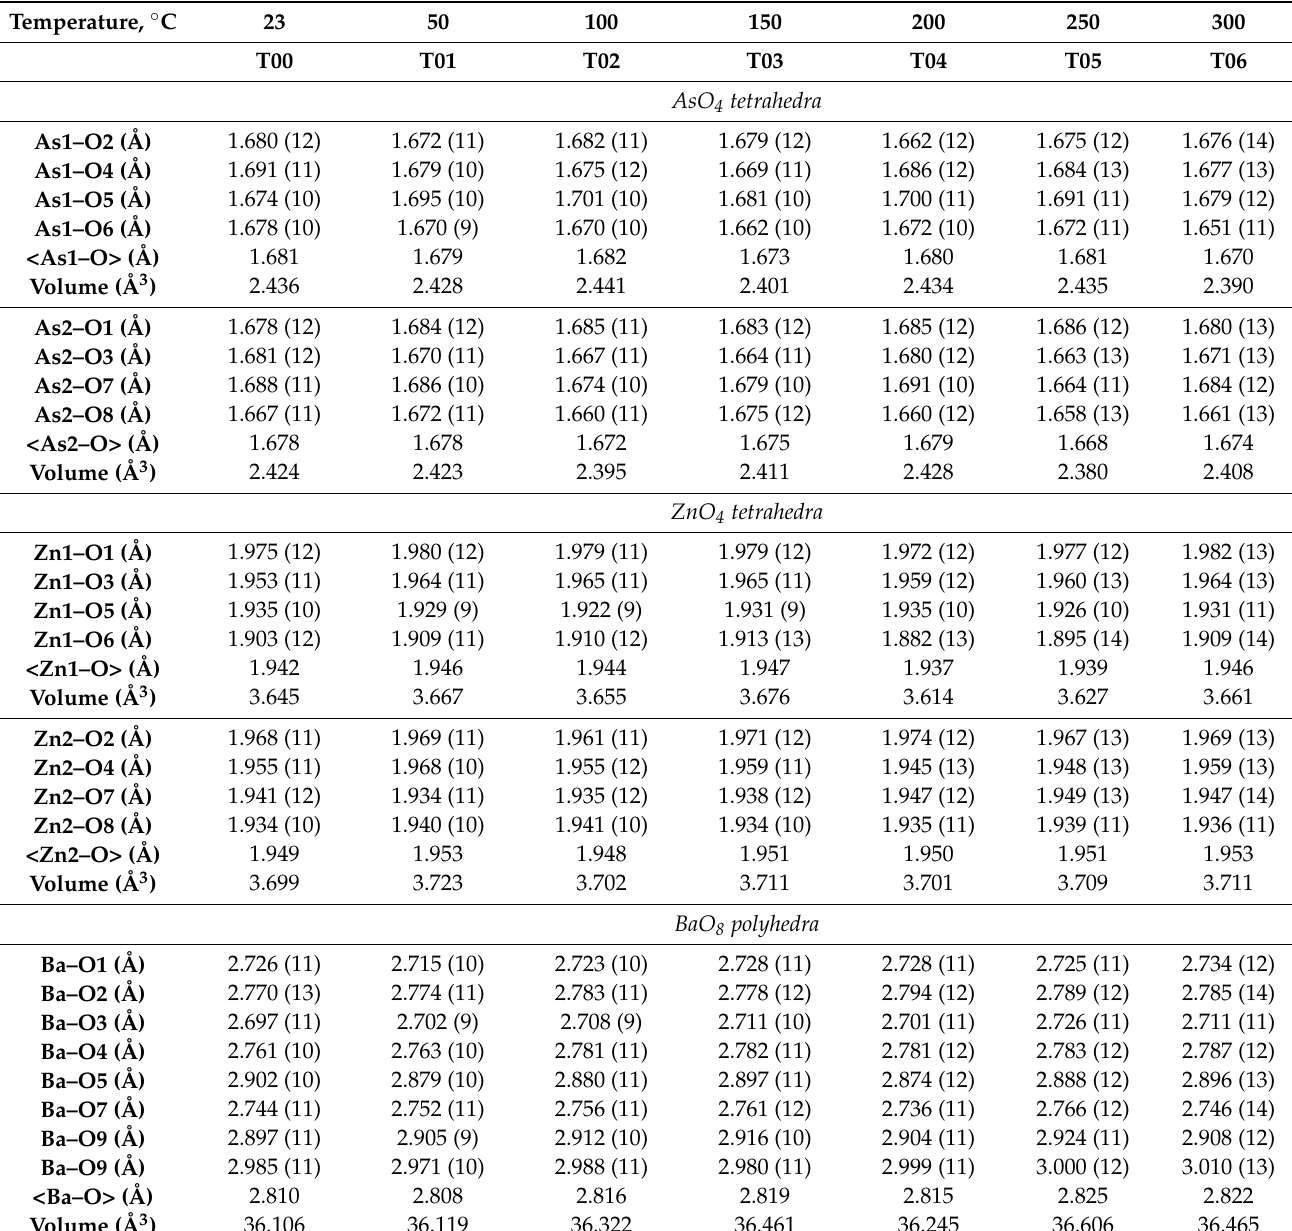
Table 2. Bond distances and polyhedral parameters in BaZn 2 As 2 O 8 · H 2 O at different